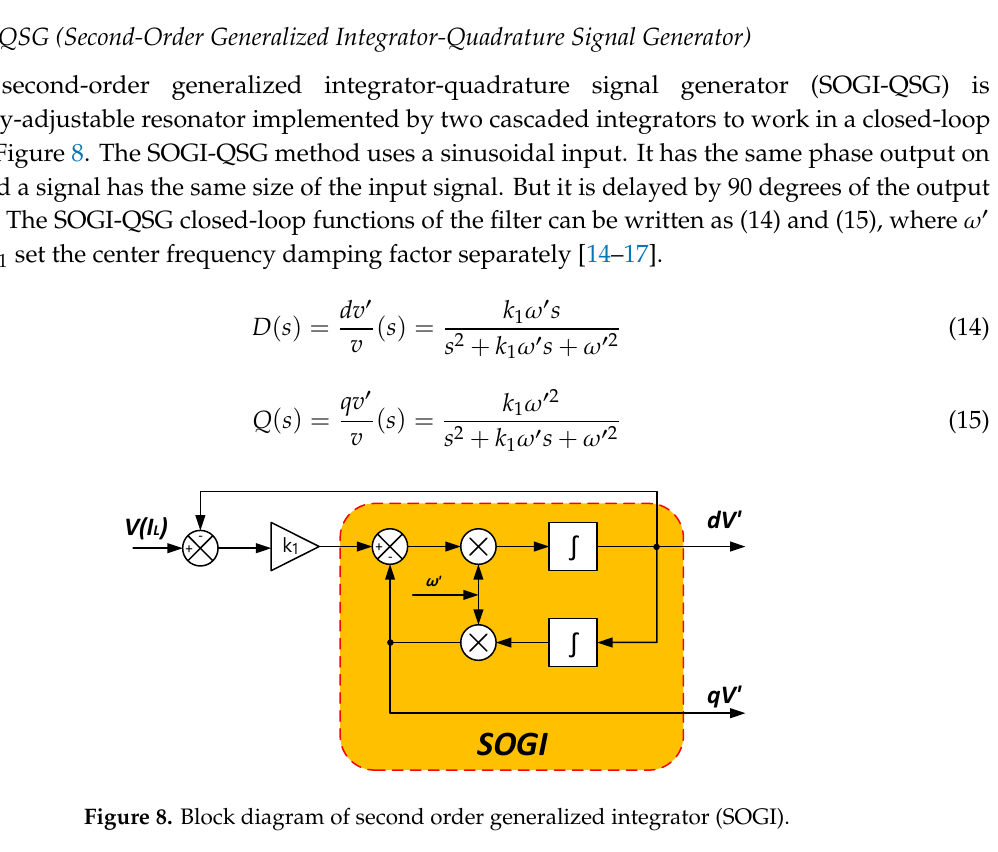
Figure 9. Bode plot of second-order generalized integrator-quadrature signal generator (SOGI- QSG). The 𝐼 𝐿 frequency can be changed, therefore, this SOGI should be able to tune its factor in case of 𝐼 𝐿 frequency change. To accomplish this, trapezoidal approximation is applied to obtain the discrete transfer function. This can express the following Equations (16)–(18).